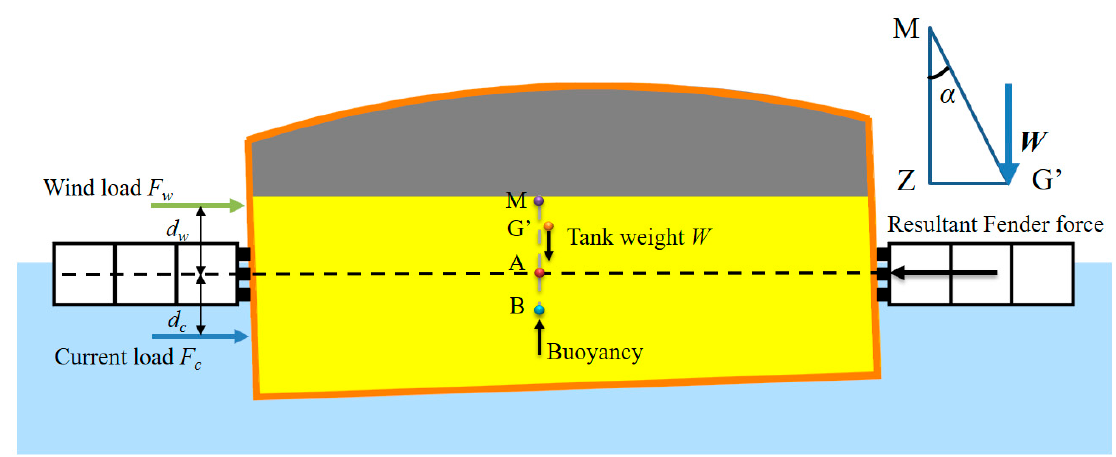
Figure 13. Forces acting on the floating storage tank.